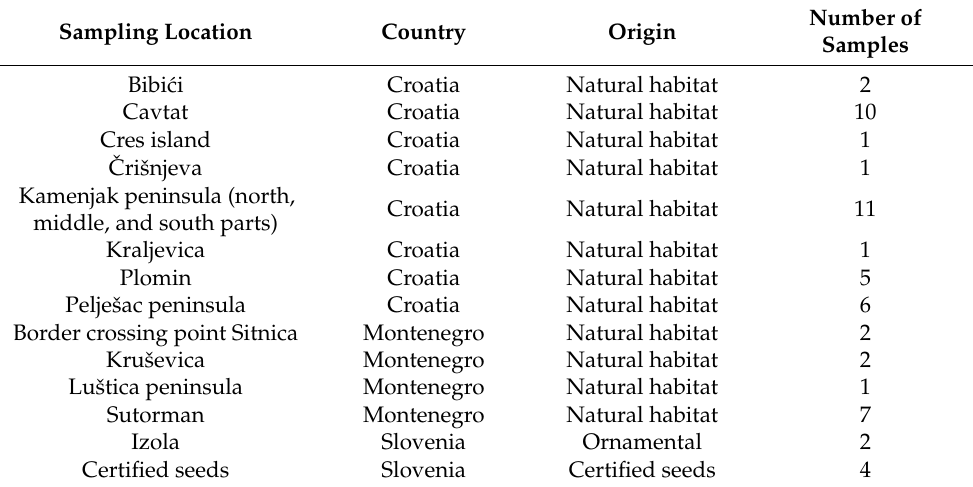
Table 1. List of sampling locations and number of HII samples from each collection, including samples from certified seeds